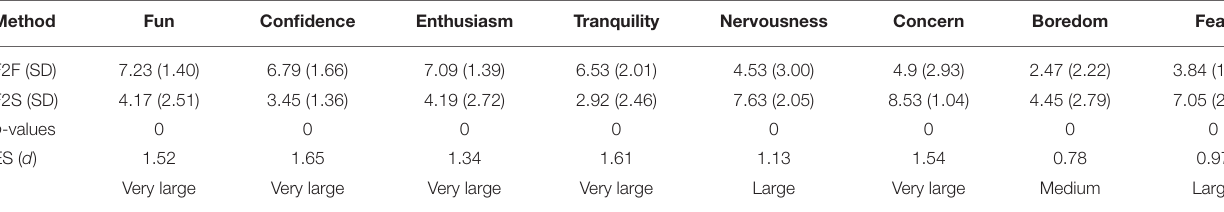
Table 6 described the PSTs’ comparison of emotions